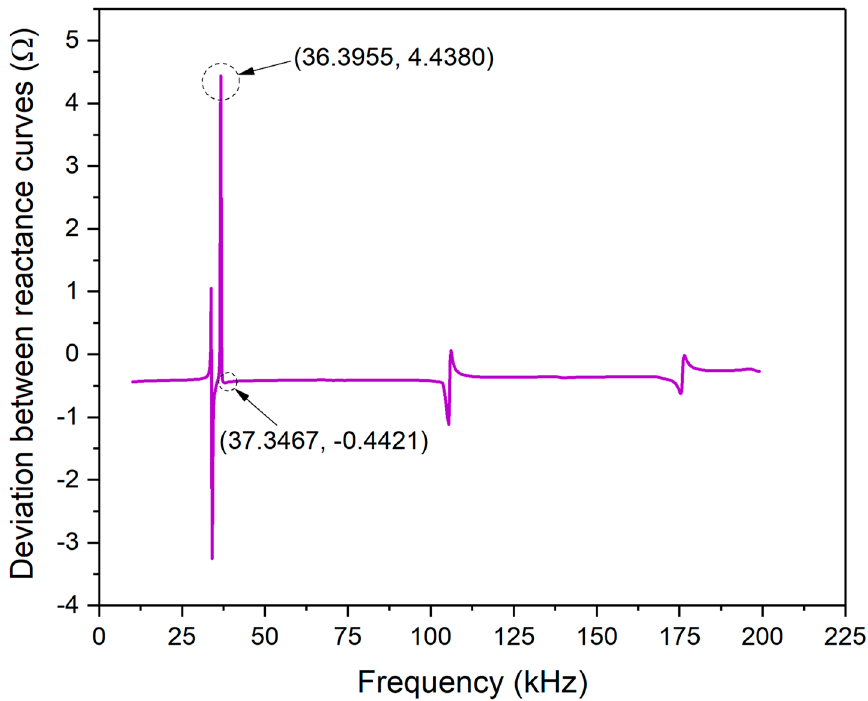
Figure 9. Reactance signal deviation between experimental and theoretical curves of PZT#1.